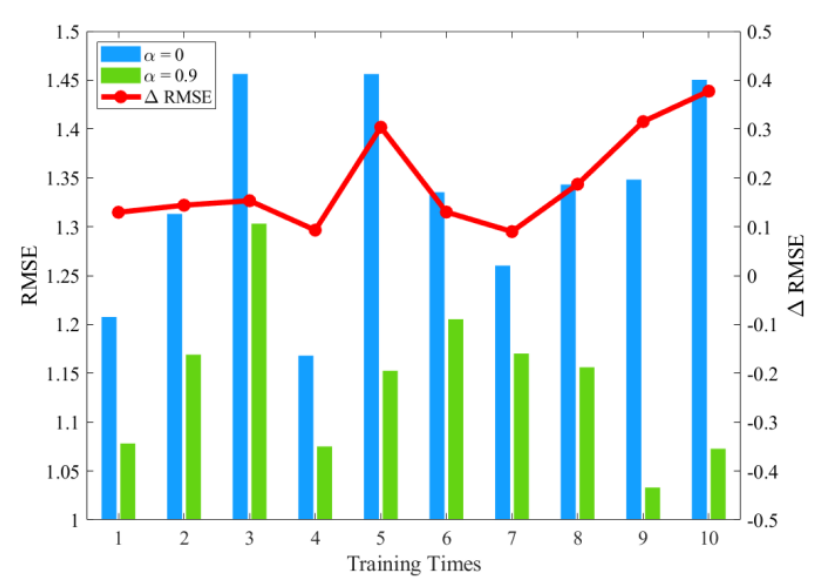
Figure 11. Performance of network with and without the momentum term.